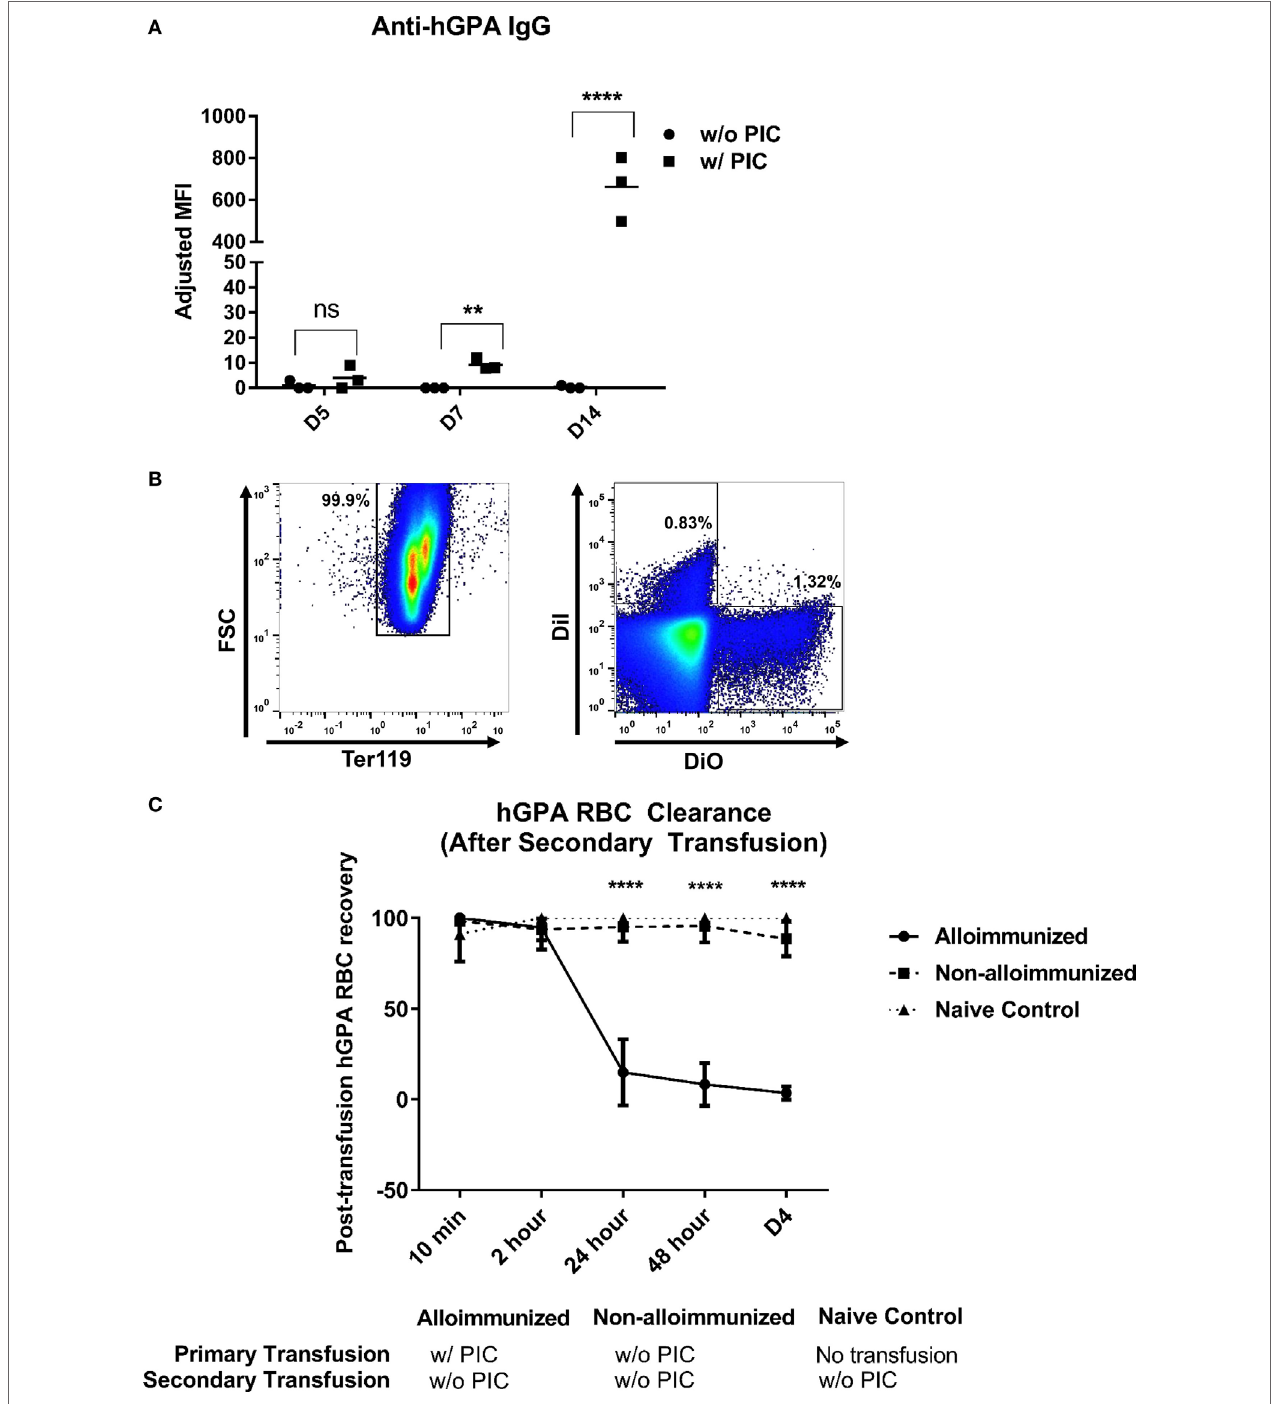
FigUre 1 | Characterization of immune responses to transfused human glycophorin A (hGPA) red blood cells (RBCs), in the presence or absence of poly IC. (a) Serum anti-hGPA IgG at day 5 (D5), day 7 (D7), and day 14 (D14) post-transfusion represented as adjusted mean fluorescence intensity (MFI) in mice transfused with hPGA RBCs in the presence or absence of pretreatment with poly IC. (B) Alloimmunized animals (previously transfused with hGPA RBCs in the presence of poly IC) or non-alloimmunized (previously transfused without poly IC) were transfused for a second time with DiI-labeled syngeneic FVB RBCs and 3,3 ′ -dihexadecyloxacarbocyanine perchlorate (DiO) labeled hGPA RBCs; representative plot showing the gating strategy for DiO and DiO-positive RBCs (pregated on Ter119 + cells). (c) Post-transfusion clearance curve in alloimmunized, non-alloimmunized, or naïve mice. Data are representative of at least two experiments ( n = 3–6 mice per group per experiment). ** p < 0.01, **** p < 0.0001 determined by Mann–Whitney U test in panel (a) and ANOVA in panel (c) , between alloimmunized versus non-alloimmunized or naïve mice. There were no significant differences at any time point between naïve and non-alloimmunized mice.